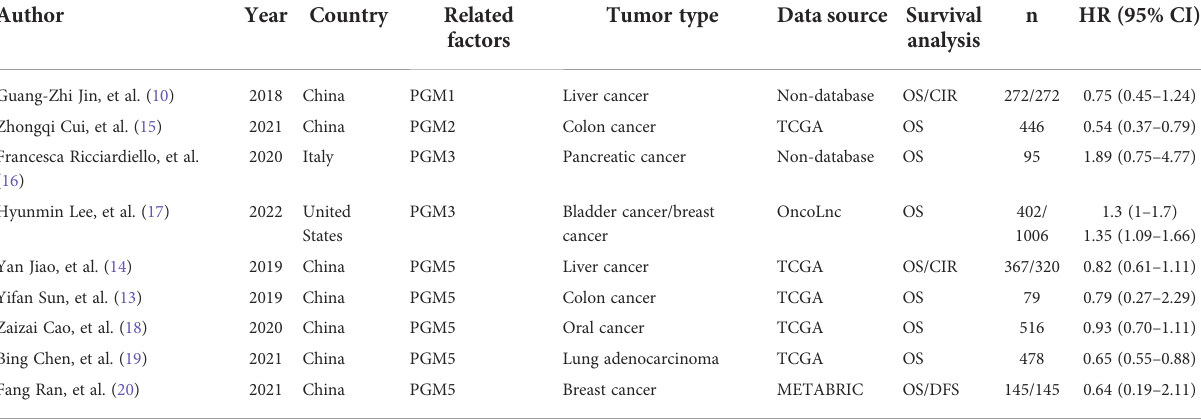
TABLE 1 Basic characteristics of the included